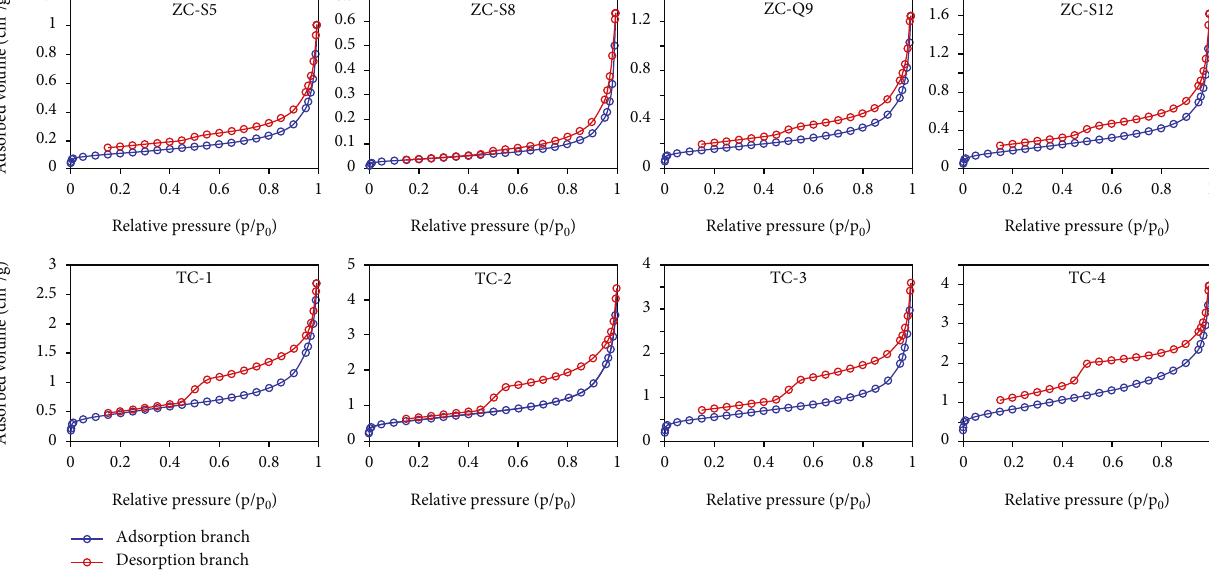
Figure 4: N adsorption and desorption isotherms of the coal 2